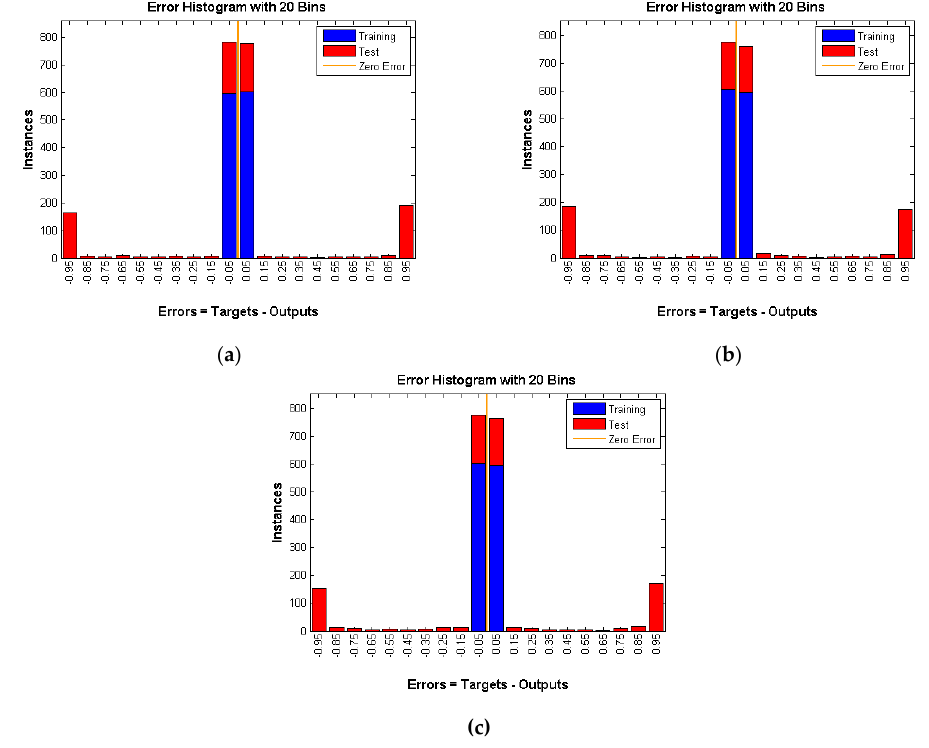
Figure 11. DAD with rate of ( a ) 0.05; ( b ) 0.1 and ( c ) 0.15.